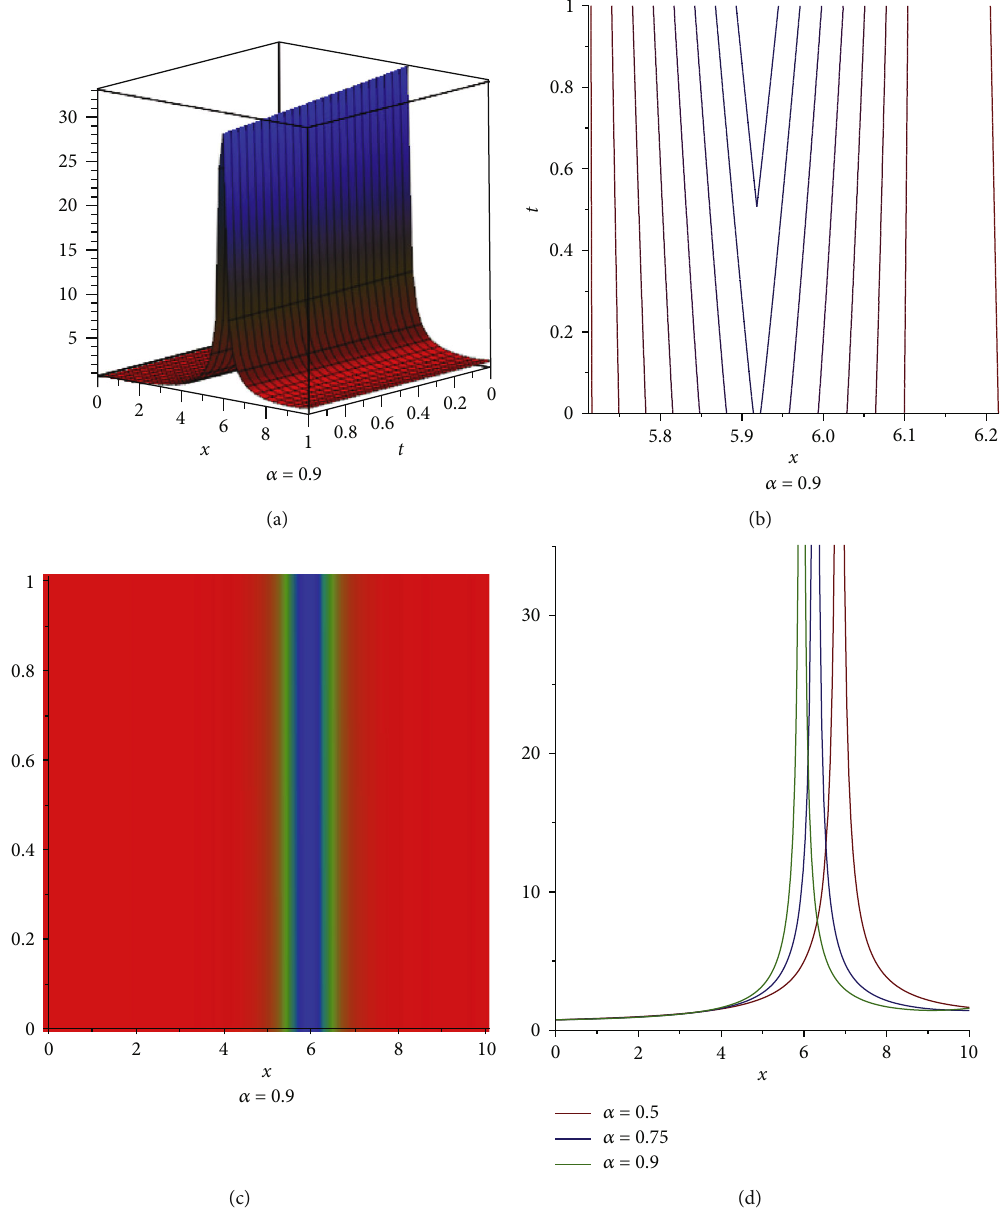
ð x , t Þj for NLFD of order α and for parameters δ 1